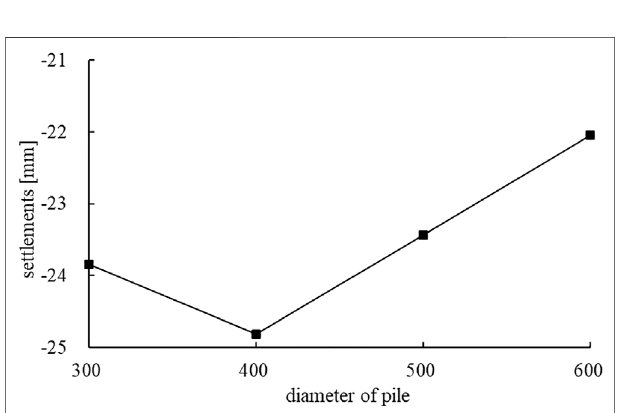
FIGURE 14 | Development of dragload and neutral plane with an increase of the diameter of the pile.